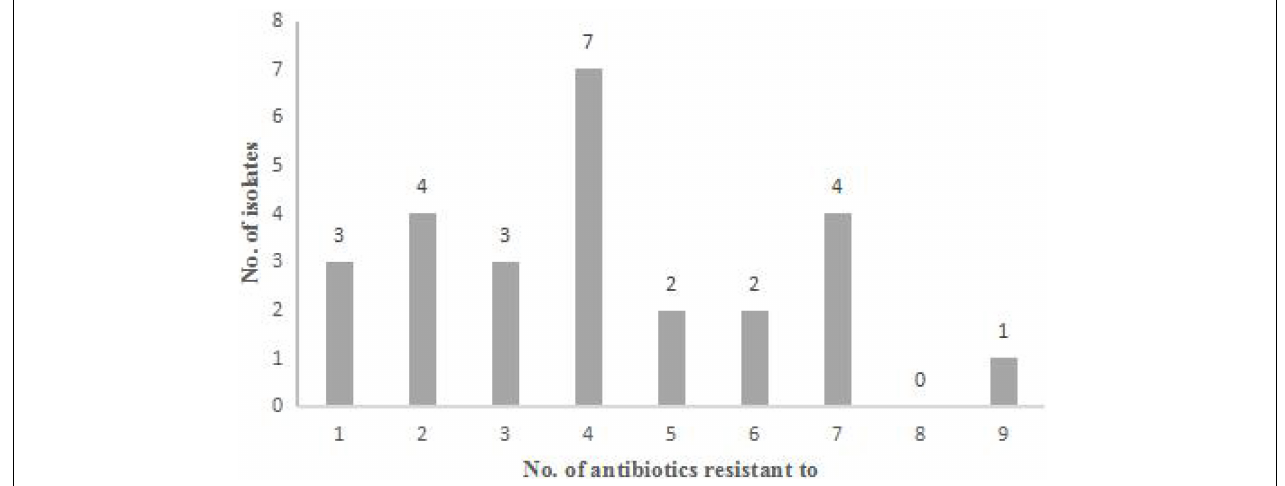
FIGURE 1 | Antibiotic resistance characteristics of 26 Staphylococcus aureus strains. Distribution of the number of antibiotics that the strains exhibit